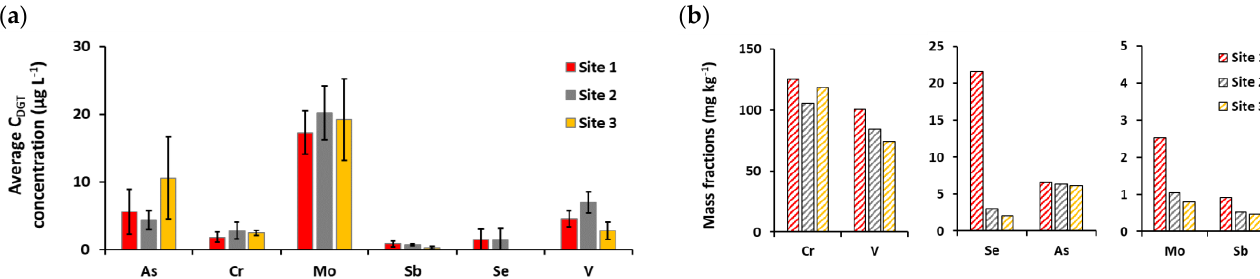
Figure 3. ( a ) Average C DGT concentrations of As, Cr, Mo, Sb, Se and V (expressed in µ g L − 1 ); ( b ) Mass fractions of Cr, V, Se, As, Mo and Sb in sediments (expressed in mg kg − 1 ) of the Raša estuary at studied